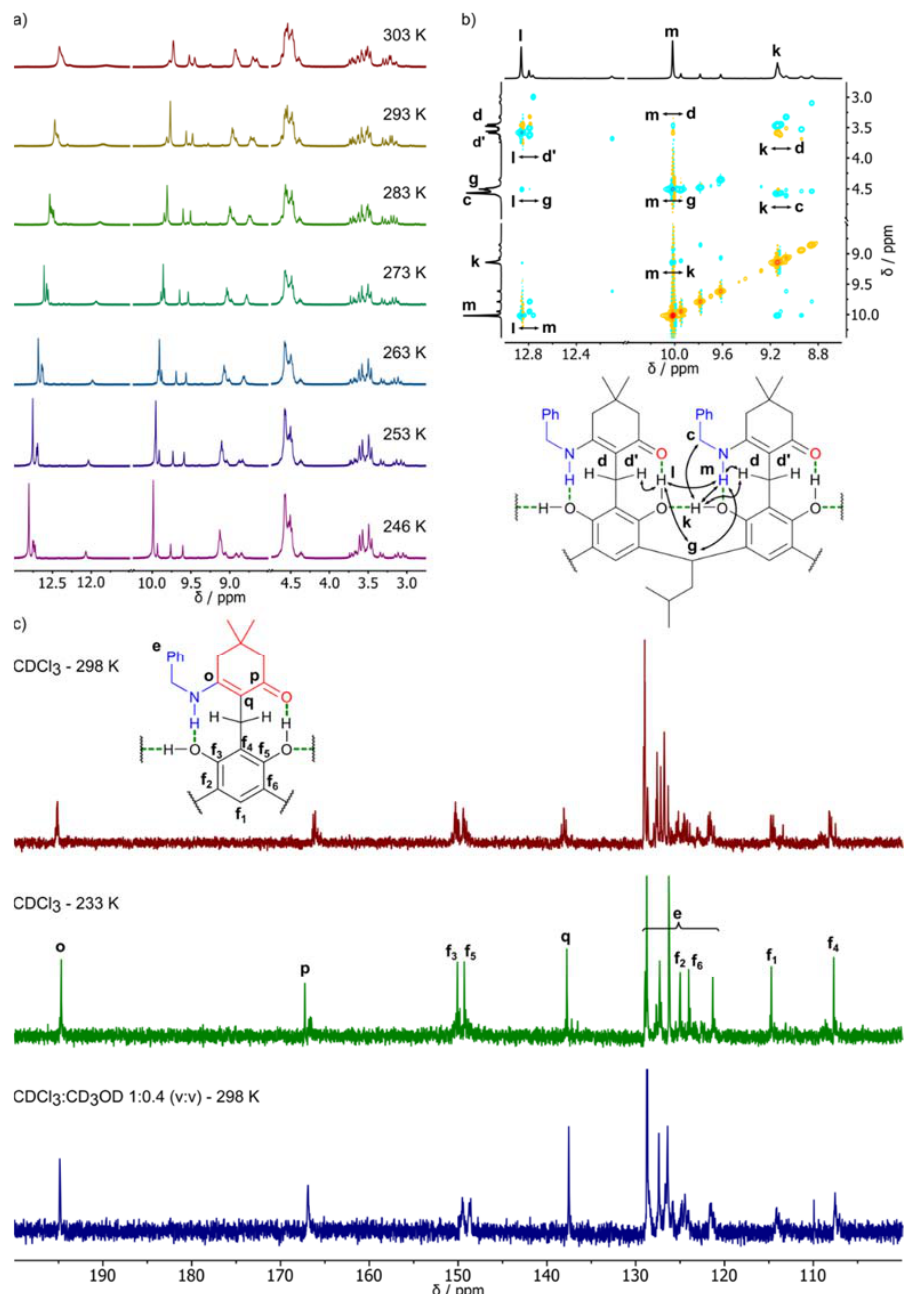
Figure 3. VT NMR spectra of 4 : ( a ) 1 H NMR (400 MHz, CDCl 3 ) temperature range 246–313 K; ( b ) partial ROESY spectrum (600 MHz, CDCl 3 , 233 K) ( c ) 13 C NMR spectra at different temperatures and solvents (all at 600 MHz).